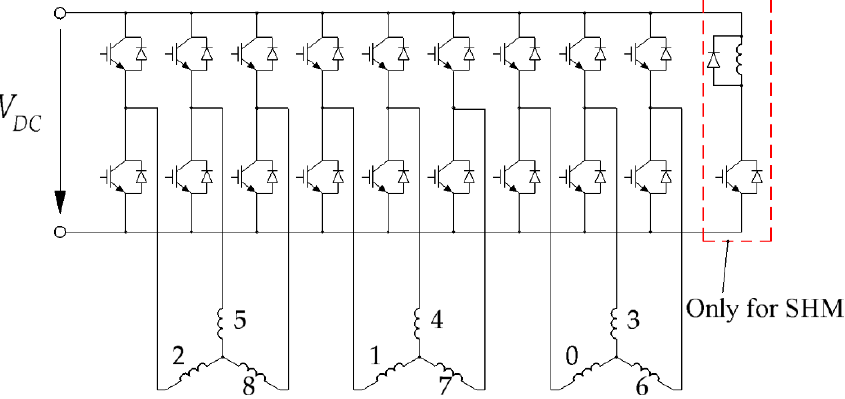
Figure 1. Sketch of the machine geometry: ( a ) interior permanent magnet synchronous motor (IP- MSM); ( b ) homopolar synchronous motor (SHM).